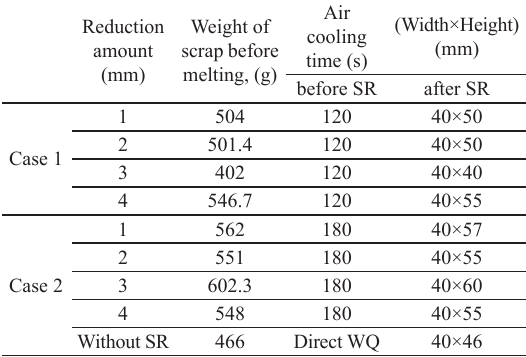
Table 1. Schematic of ingot soft reduction experiment.